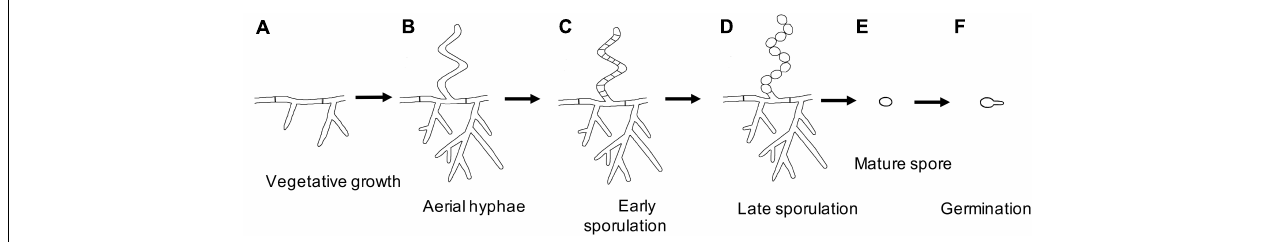
FIGURE 1 | Streptomyces life cycle. Schematic representation of the major growth stages: (A) Vegetative hyphae, (B) Early sporulation begins with aerial hyphae formation, (C) Synchronous septa formation to produce immature spores, (D) Spore maturation, (E) Release of mature spores, and (F) Germination into vegetative